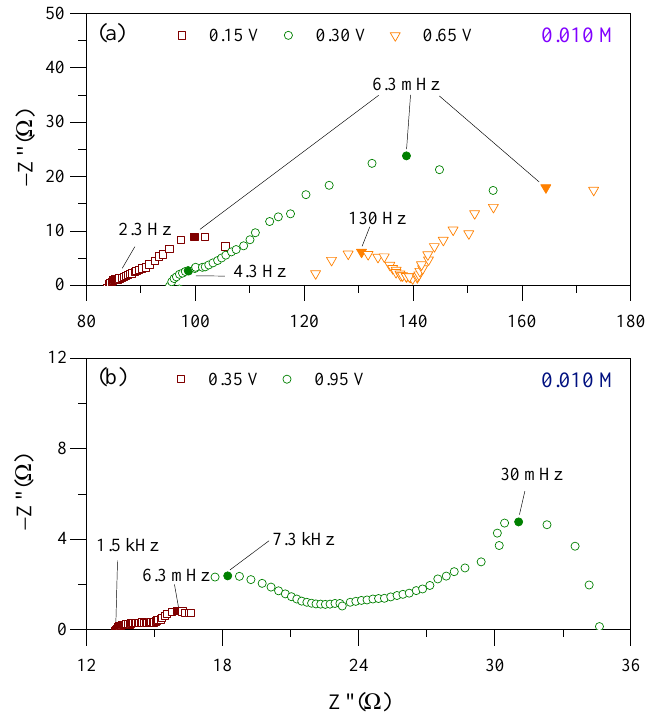
Figure 6. Electrochemical impedance spectroscopy spectra for the ( a ) 0.01 M and ( b ) 0.1 M H x PO 43 − x solution at pH 7.2. The impedances were obtained at bias potentials comprehending the i < i lim,1 (red), i = i lim,1 (green), and i lim,1 < i < i lim,2 (orange, when applicable) region of the polarization curve. Solid points refer to characteristic frequencies.